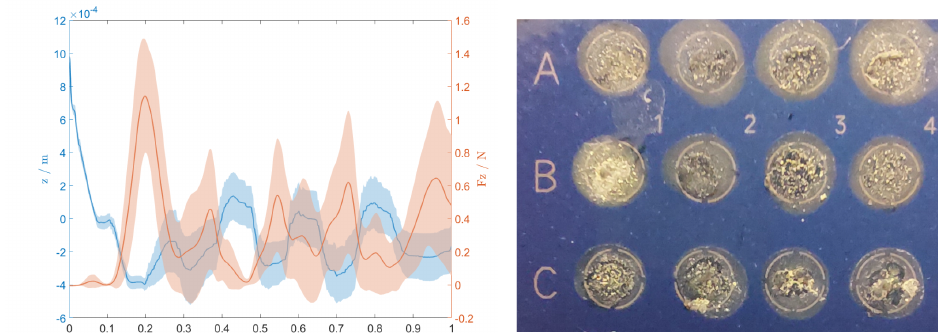
Figure 5. The contact force between the end–effector needle and MALDI target plate and the corresponding compensated z position ( left ), and an image of deposited colonies on the MALDI target plate after being covered with the matrix solution ( right ).